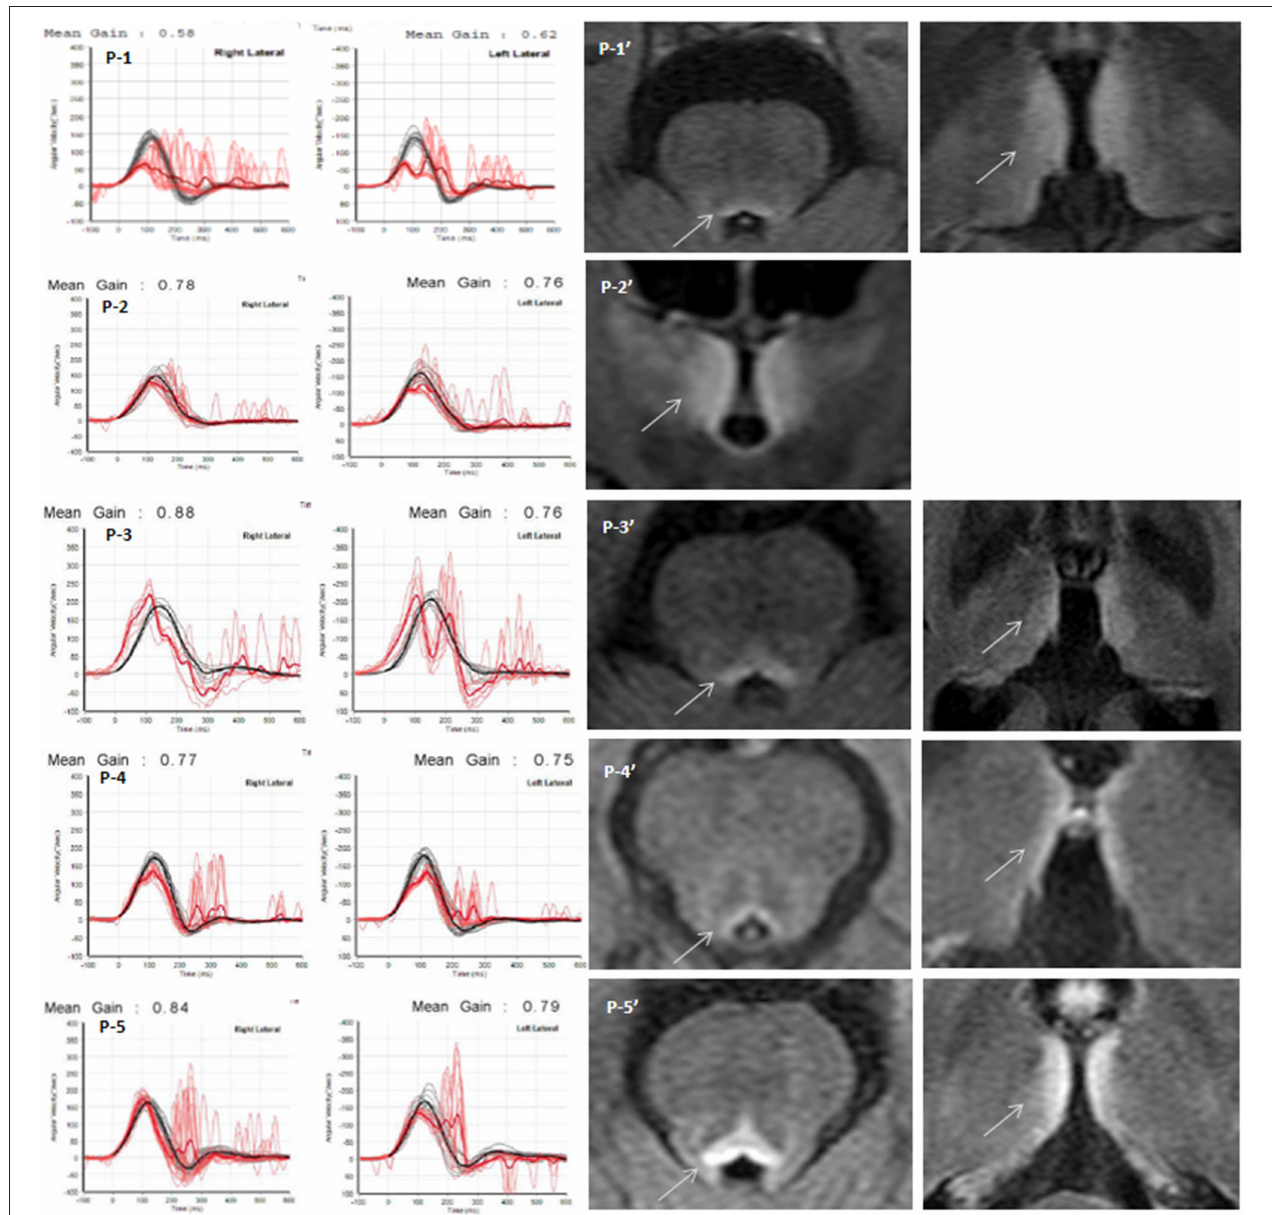
FIGURE 1 | Quantitative video head impulse test (vHIT) and brain MRI. Left panels : Within 5 days after symptom onset, eye (in red) and head (in black) velocity traces for right and left head impulse tests of each Wernicke’s encephalopathy patient are plotted against time (20 trials per canal) (P1 ∼ P5). Vestibulo-ocular reflex (VOR) gain (mean ± standard error) of each patient was significantly reduced, and overt catch-up saccades developed during passive head impulses. Note that eye velocity traces are inverted to allow for better visualization and comparison with head velocity traces. Mean gain values (eye velocity/head velocity) are shown in the upper part of the figure. Right panels: Brain magnetic resonance image (P1 ′ ∼ P5 ′ ) studies (fluid-attenuated inversion recovery images) show bilateral symmetrical lesions (white arrows) in the medial vestibular nucleus, periaqueductal region, around the hypothalamus, and periventricular regions of the thalamus.